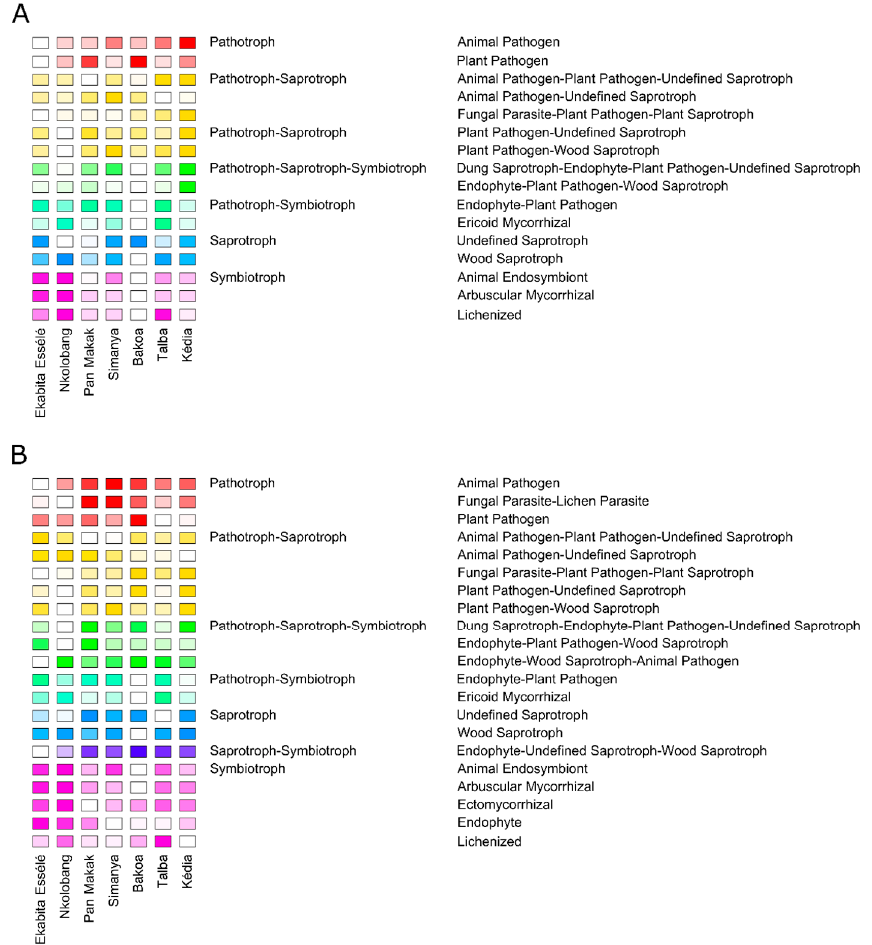
Figure 6. Functional guilds of fungal endophytes in T. cacao leaves. The relative abundance of fungal sequences (sequence richness) per guild ( A ) and the proportion of zOTUs (zOTU richness) per guild ( B ) is shown for the seven sites. The analyses are based on 31.5% of the zOTUs ( n = 1766 zOTUs). The sequence richness and zOTU richness were calculated by the number of sequences assigned to a specific guild divided by the number of all assigned sequences and by the number of zOTUs assigned to a specific guild per sample divided by the number of zOTUs per sample, respectively.